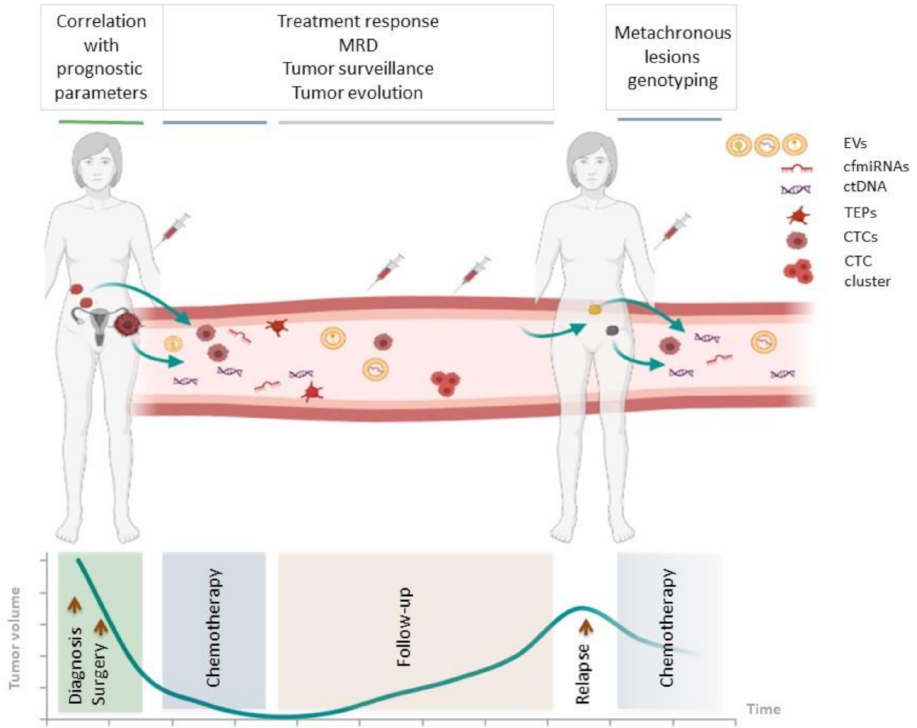
Figure 1. Applications of liquid biopsy in HGS-EOC. Scheme illustrating the information that can be obtained from the analysis of tumor-derived elements circulating in the bloodstream of HGS-EOC patients at different times, i.e., at the time of diagnosis, during and after chemotherapy, at follow up and relapse. MRD, minimal residual disease; EVs, extracellular vesicles; cfmiRNA, circulating- free microRNA; ctDNA, circulating-tumor DNA; TEP, tumor-educated platelet; CTC, circulating tumor